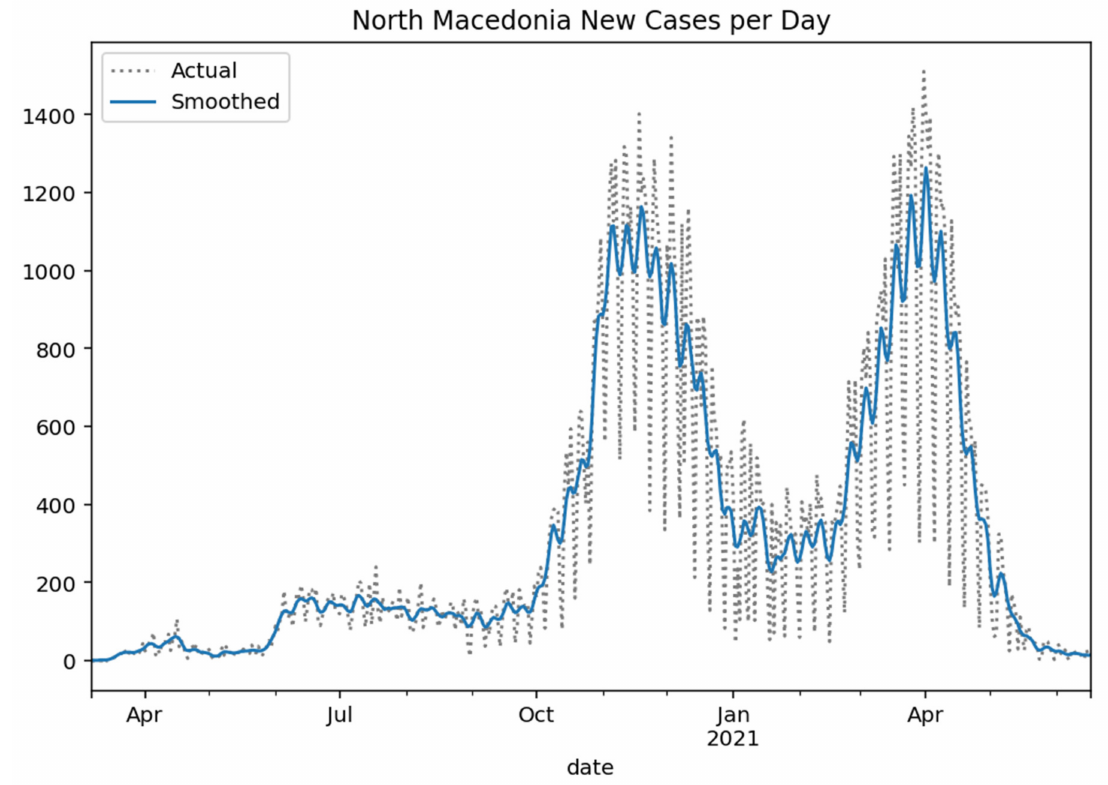
Figure 5. North Macedonia new cases per day (Gaussian